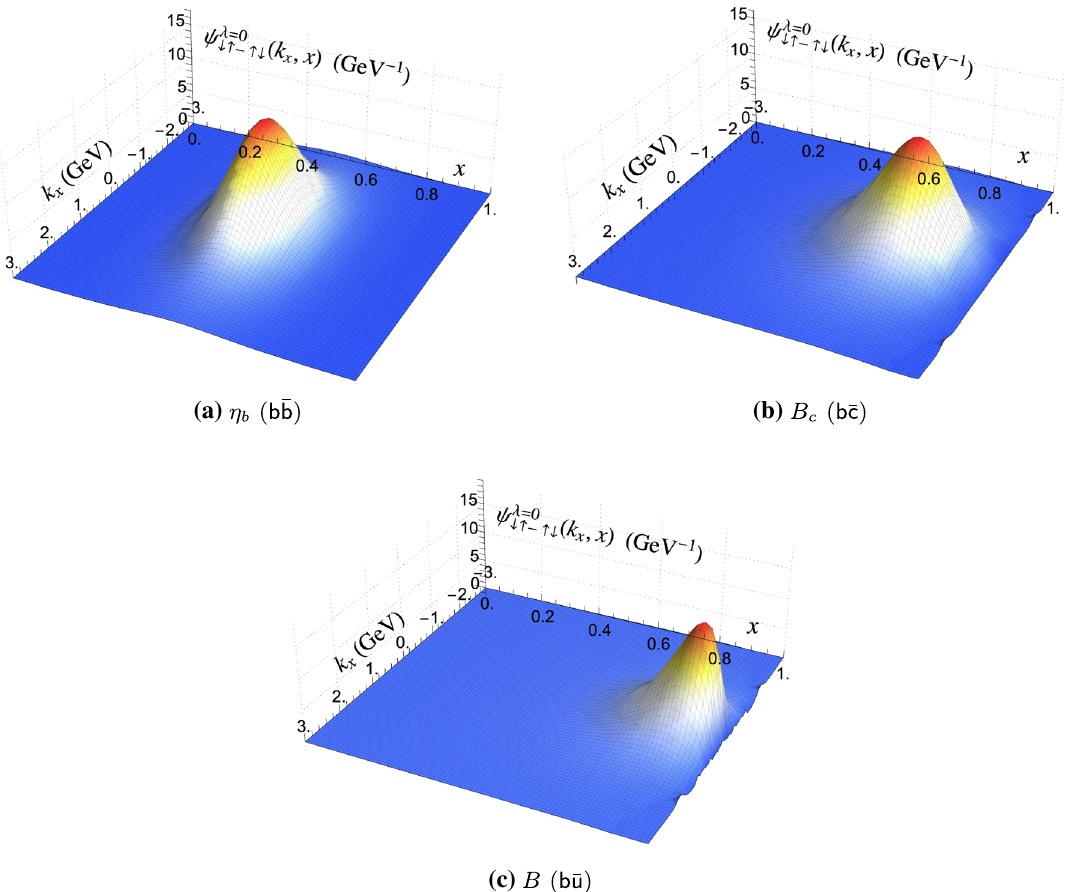
Fig. 2 The ground state (1 1 S 0 ) LFWFs of η b , B c , and B at θ q = 0. Locations of peaks along x -axis vary significantly according to the quark mass fractions of each